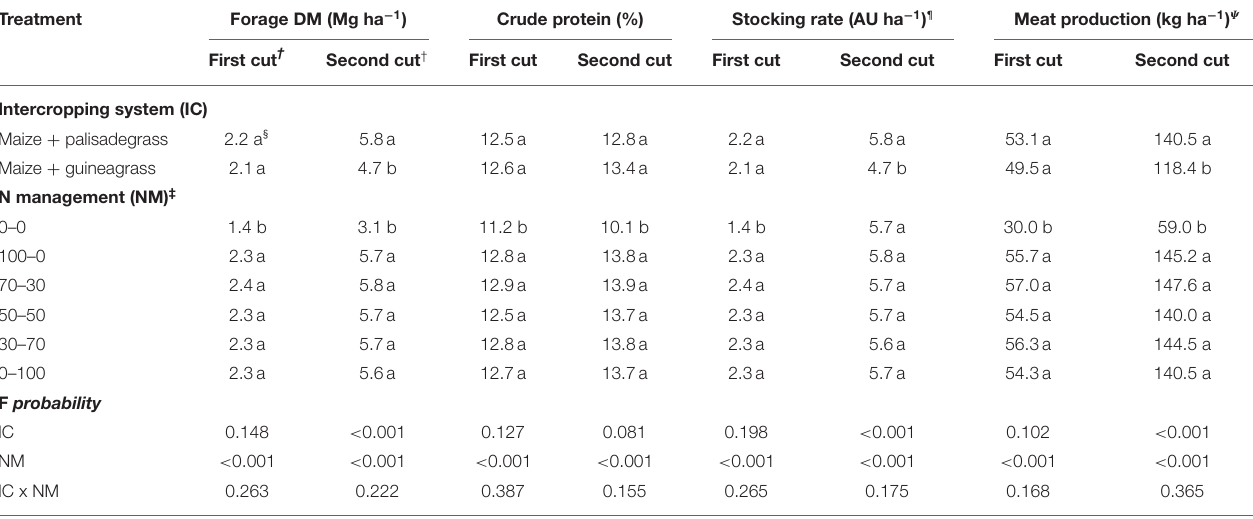
TABLE 3 | Forage dry matter (DM) production and crude protein (CP) concentration, estimated animal stocking rate, and estimated meat production as affected by intercropping systems and N management in three growing seasons and ANOVA significance. Treatment